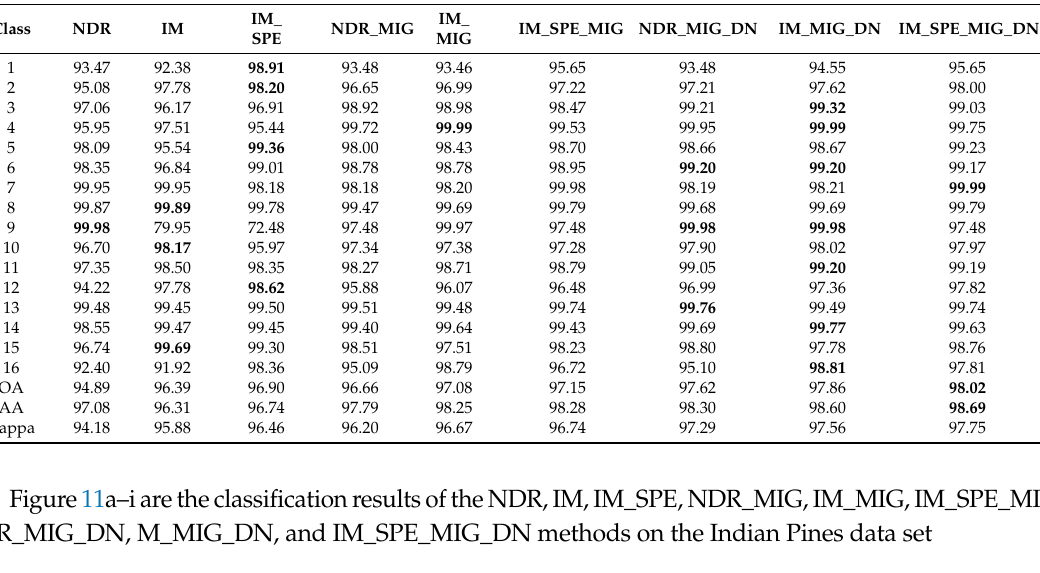
Table 3. The classification results on Indian pines (%).